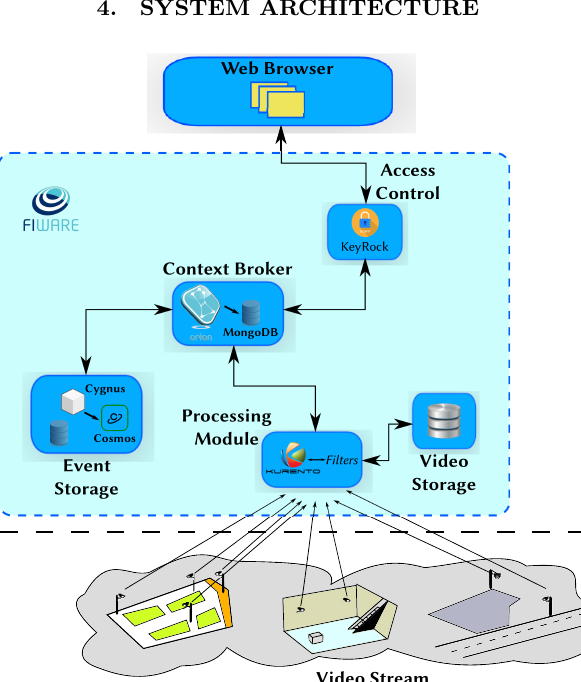
Figure 2. System